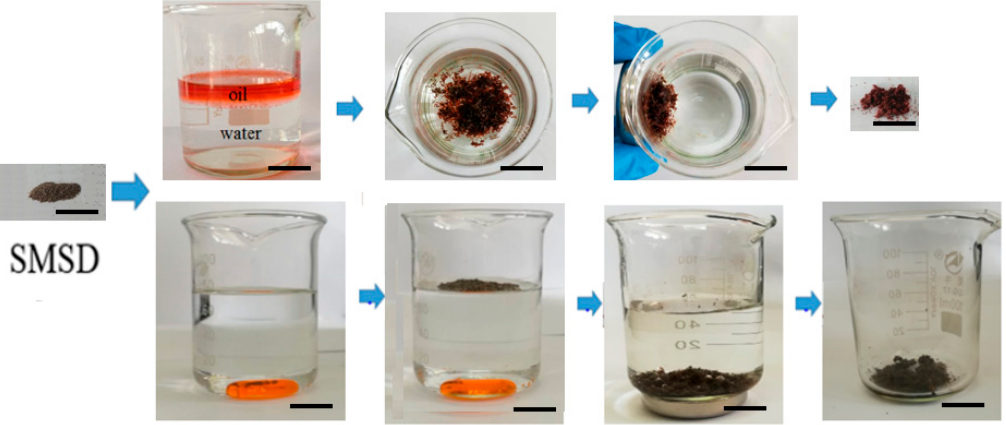
Figure 8. Photographs of absorption of ethyl acetate and tetrachloromethane (colored with Sudan III) with SMSD. Scale bar, 2 cm.